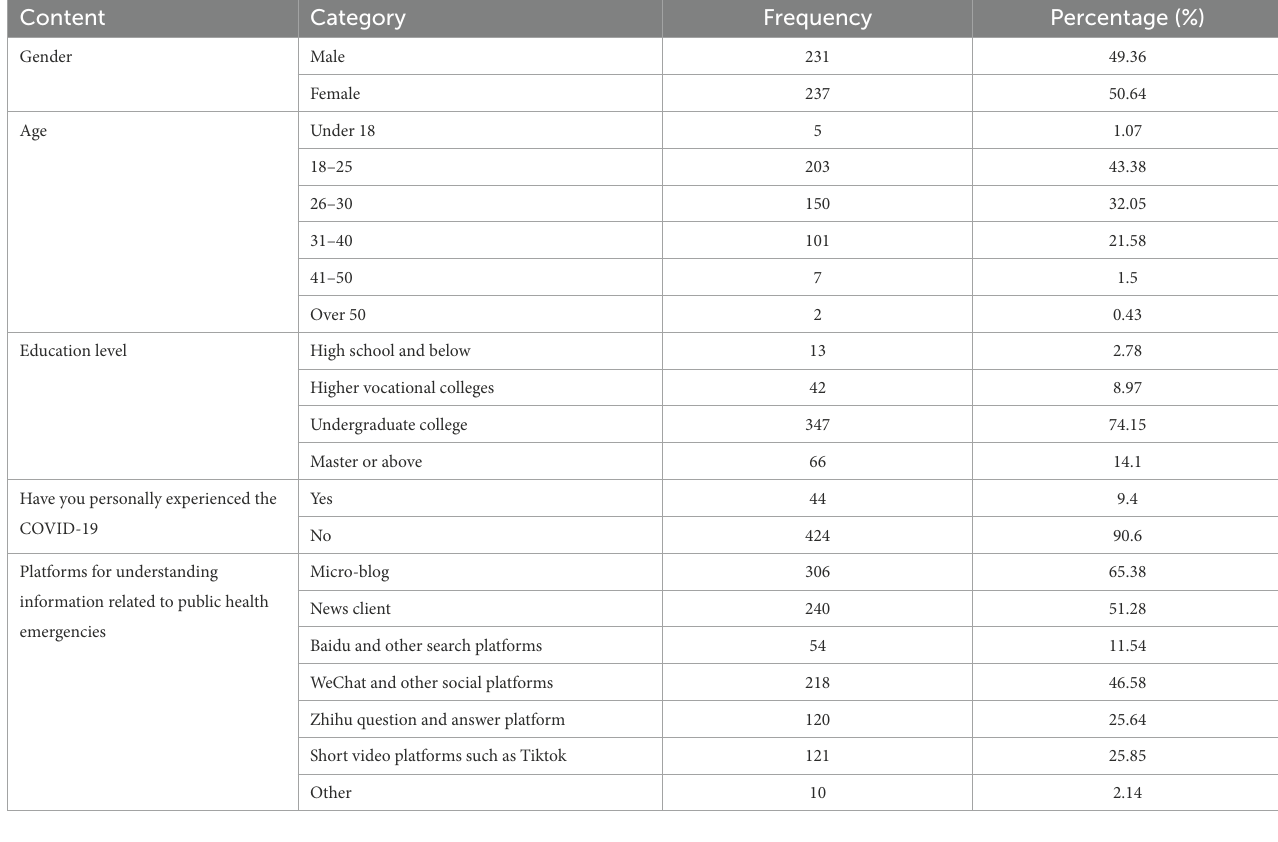
TABLE 6 Sample description and statistical results.